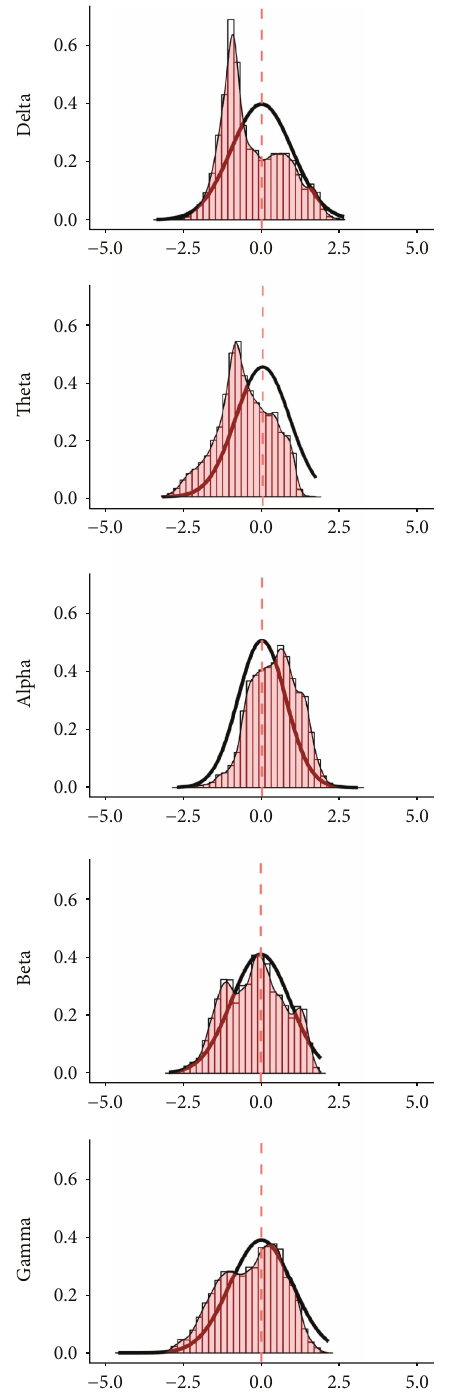
Figure 2: Resting-state activity (PSD) cortical t -value distribution. Histograms with red bars and the superimposed density plot with the thin line were calculated from the observed t -value distribution for the frequency bands under investigation. The tick black line shows a theoretical null-hypothesis distribution, with zero mean and zero median and the same variability of the empirical distribution. x -axes: t -value; y -axes: frequency of cortical vertices exhibiting a speci fi c t -value expressed as proportion on the entire sample